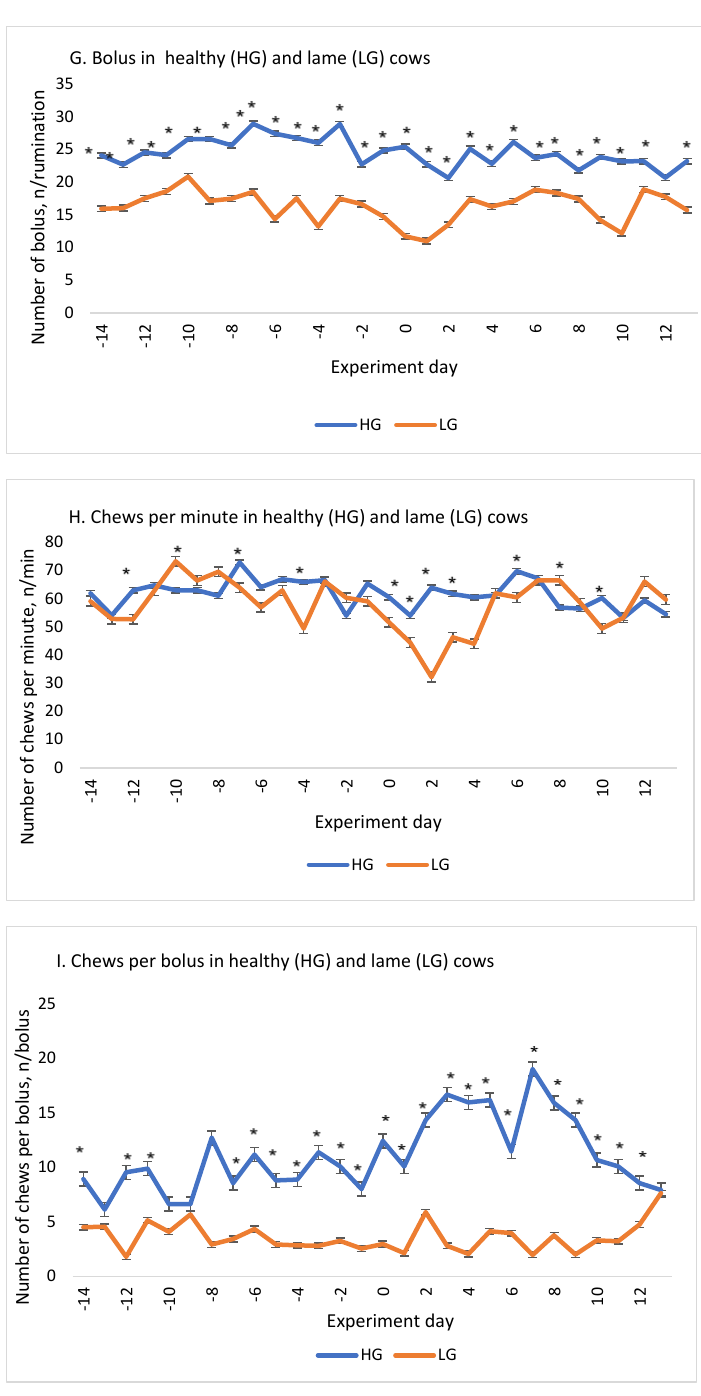
Figure 2. Changes in ingestive-related behaviors parameters by day of the experiment. * shows that the values of the HG and LG groups differ significantly at p < 0.05. RT—Rumination time (time in minutes spent for rumination chews); ET—Eating time (time in minutes spent for eating chews); DT—Drinking time (time in minutes spent for drinking); RC—Rumination chews (chews during rumination for mechanical breakdown of the regurgitated materials); EC—Eating chews (number of prehension bites); DG—Drinking gulp (total number of drinking gulps while drinking); B—number of boluses per rumination) CM—Chews per minute (chews for one minute); CB—Chews per bolus (chews performed during rumination). LG—lame cows’ group, HG—healthy group. Days ‘ − 14’ to ‘ − 1’ denote the experimental period before the onset of clinical signs of lameness (day ‘0’) in the LG group, and days ‘1’ to ‘13’—the period after the start of